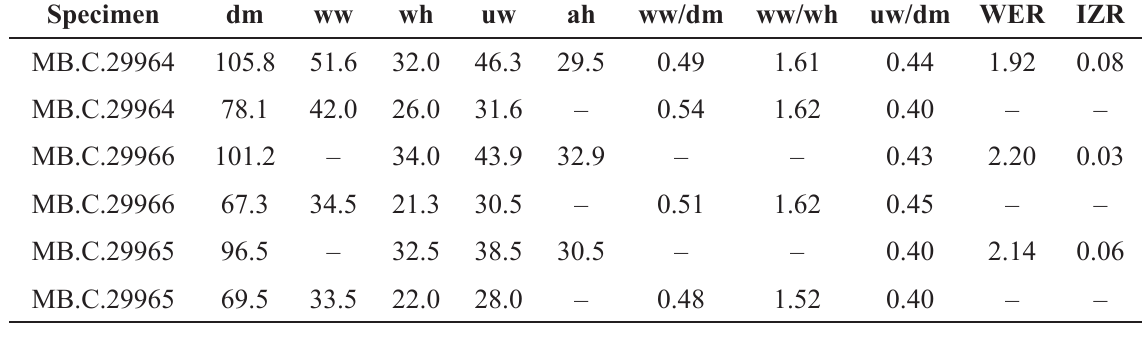
Table 22. Conch dimensions (partly estimated) and ratios of selected specimens of Esfahanites armatus Korn & Hairapetian gen. et sp. nov. from Baghuk